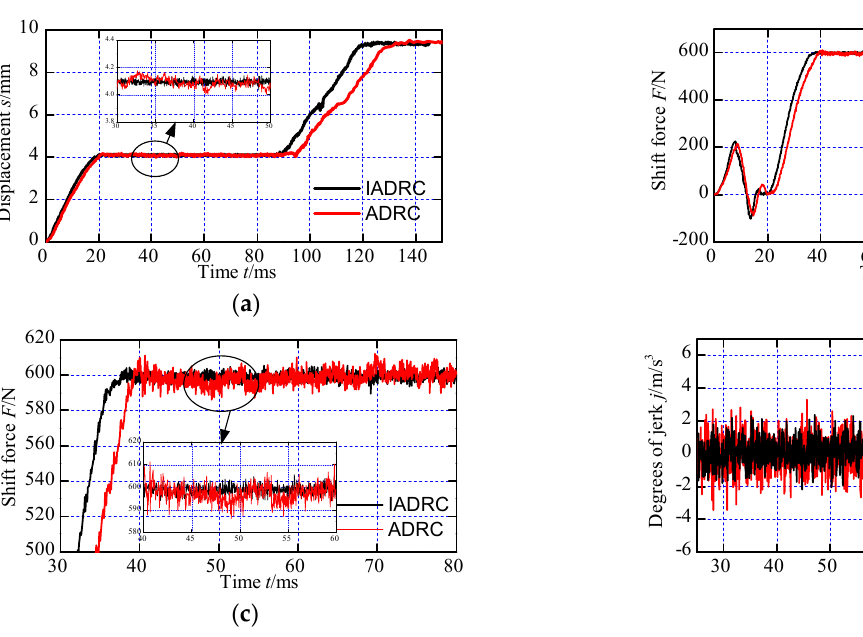
Figure 16. Gearshift experiment results (speed difference 300 r/min): ( a ) displacement; ( b ) shift force; ( c ) amplified shift force during the synchronization process; and ( d ) degree of jerk.